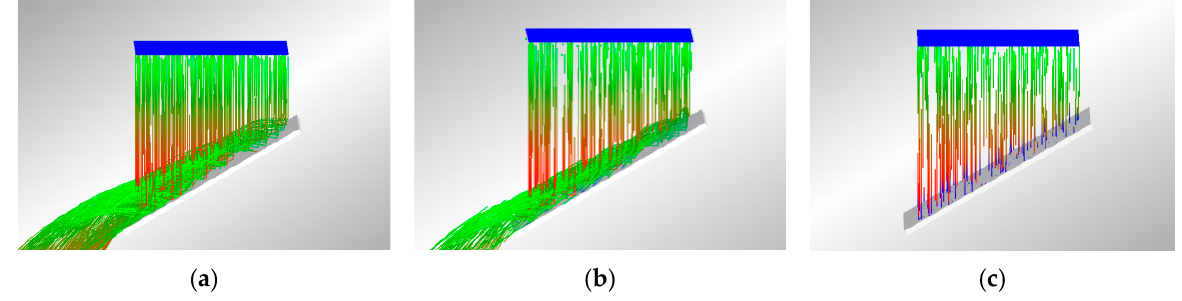
Figure 4. The deposition of dust particles on the solar panel of 100 µ m fine sand particles under static wind with different coherent energy parameters. ( a ) K = 0.5 × 10 6 Jm − 3 . ( b ) K = 1.05 × 10 6 Jm − 3 . ( c ) K = 3.5 × 10 6 Jm − 3 .